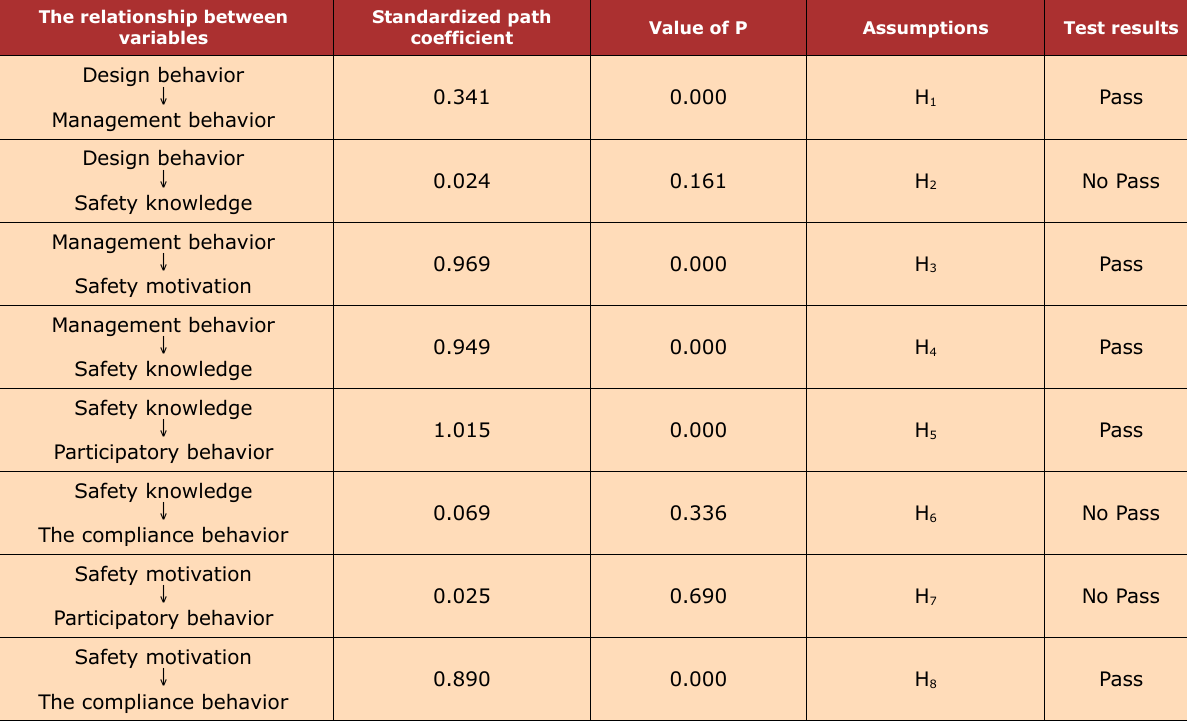
Table 6. Path Coefficients of the Theoretical Model and Hypotheses